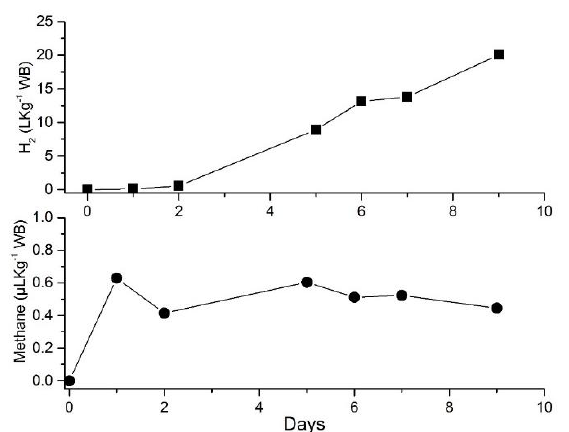
Figure 5. Kinetics of hydrogen and methane production in a closed system mean values (n = 2; three repetition of analysis in each sample). WB = wet biomass.